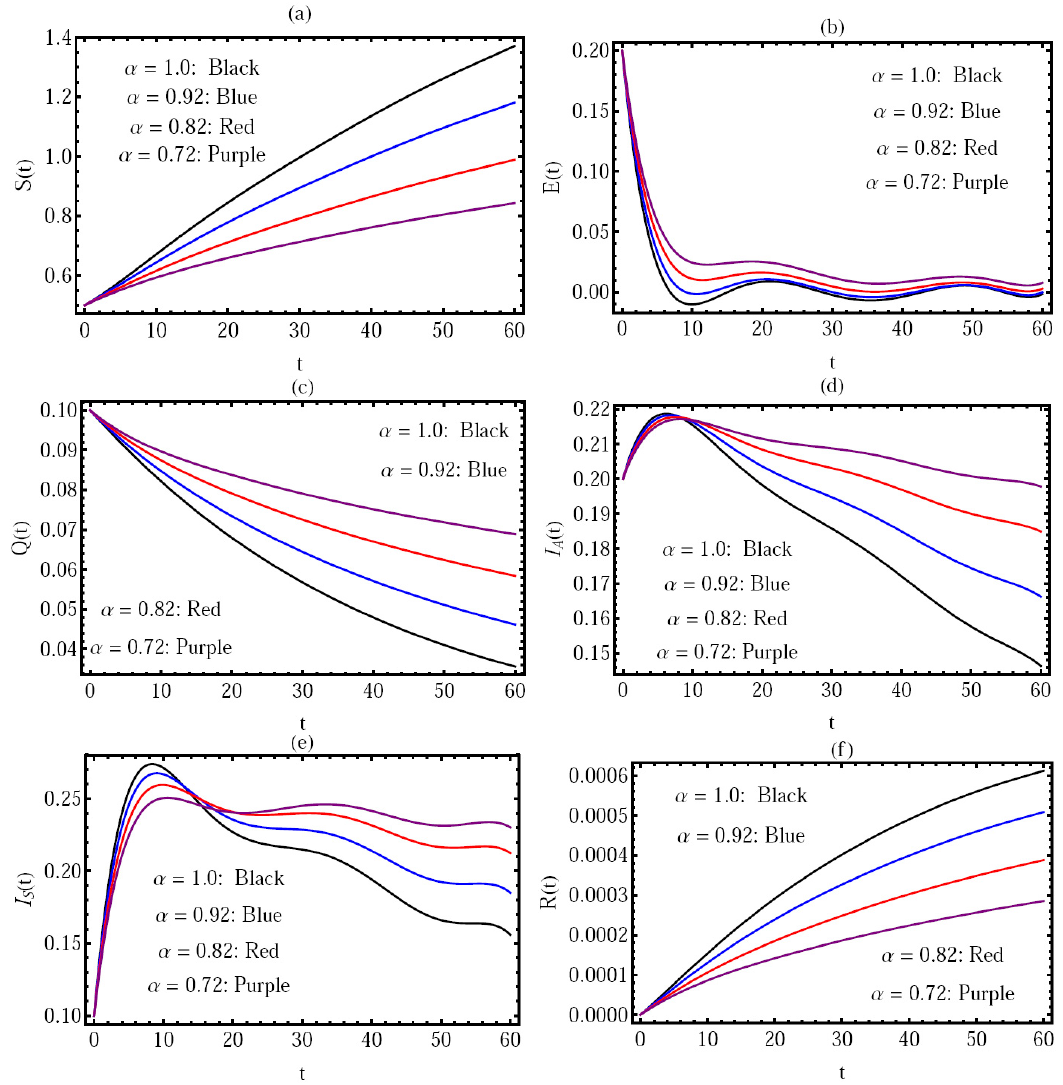
Figure 4. The solution by FDM via different values of α ( a – f